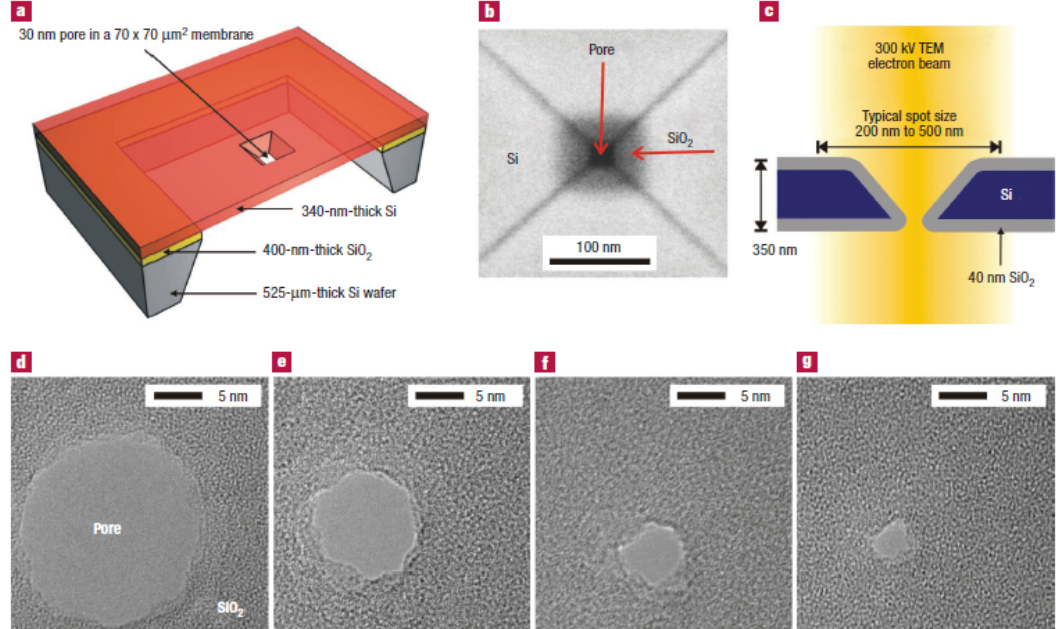
Figure 7. Fabrication of silicon oxide nanometer-sized pores. ( a ) Cross-section of the device. It consists of a 340 nm thick free-standing single-crystalline silicon membrane, supported by a 52 μ m thick wafer etched by KOH. The membrane contains one or more submicrometer, pyramid-shaped pores, anisotropically etched with KOH from the top. ( b ) Top-view scanning electron micrograph of a nanofabricated pore after thermal oxidation. The pore is about 20 × 20 nm 2 and is surrounded by an SiO 2 layer of about 40 nm thickness. ( c ) Cross-section of the pore inside the electron microscope; ( d – g ) sequence of micrographs obtained during imaging of a silicon oxide pore in a TEM microscope. The electron irradiation causes the pore to shrink gradually to a size of about 3 nm. Reprinted with permission from reference [105]. Copyright 2003 Nature Publishing